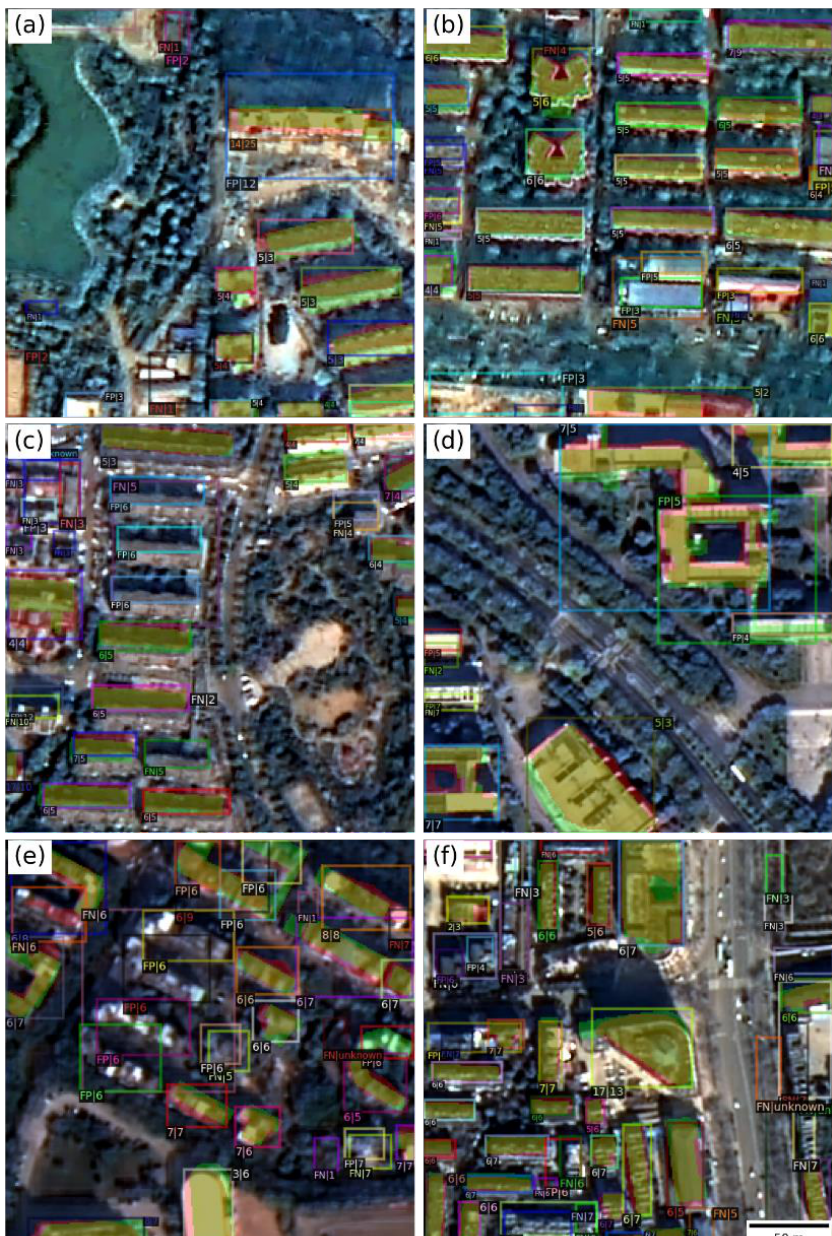
Figure 7. Prediction result of MBB in mode A. There are six subfigures ( a – f ), which correspond to six selected patches, respectively. Each subfigure shows the “TP”, “FP”, and “FN” prediction of MBB in mode A. The color of the bounding boxes has no specific meaning, just in order to distinguish different building instance. Most bounding boxes have a pair of numbers separated by “|”. For TP samples, the first number is the NoS prediction of the model and the second is the NoS GT. The bounding boxes with pairs start with “FP”/“FN” are “FP”/”FN” objects and the numbers of those are predicted/true NoS. All predicted values shown in the figure have been rounded up or rounded down to the nearest decimal. For example, a bounding box with the label “4|6” indicates that the bounding box is the prediction of a “true positive” sample whose NoS prediction and ground truth is 4 and 6, respectively. A bounding box with the label “FP|3” indicates that the bounding box is the prediction of a “false positive” sample whose NoS prediction is 3. A bounding box with the label “FN|1” indicates that the bounding box is the ground truth of a “false negative” sample whose NoS ground truth is 1. For every TP sample, the TP/FP/FN pixels of segmentation are shown in transparent